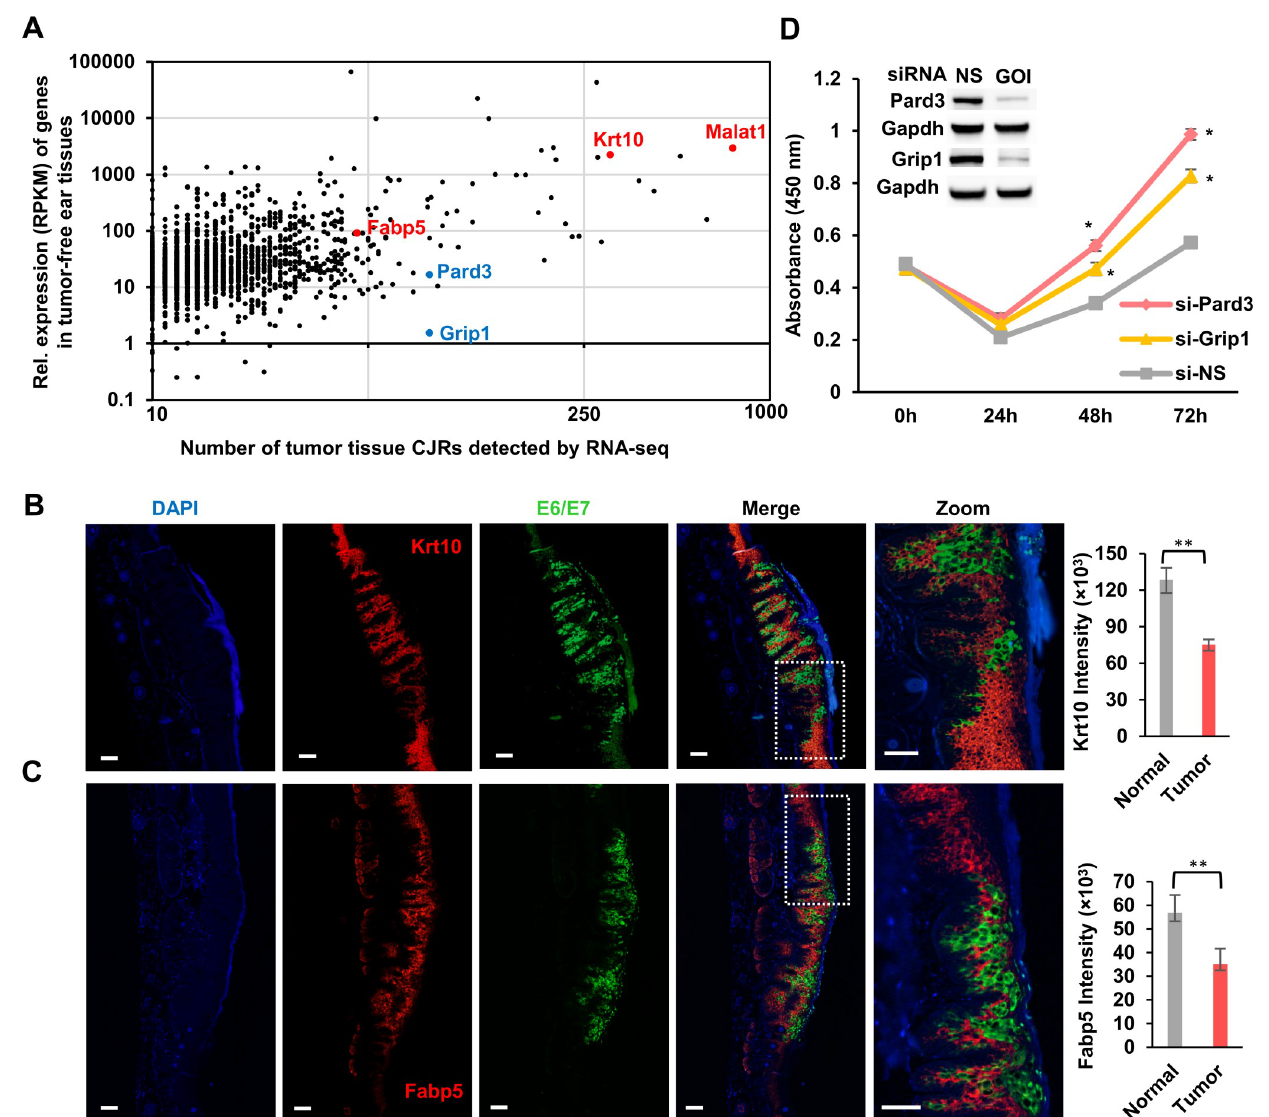
Fig 6. MmuPV1 integration, host gene expression, and cell growth. A, MmuPV1 integration sites were found in genes that are expressed at both high and low levels. Each dot indicates a gene with the indicated level of expression (RPKM) in tumor-free ear tissues and the number of virus-host CJRs obtained from all tumor tissues by RNA-seq. RPKM is the Reads Per Kilobase of transcript per Million mapped reads in RNA-seq. B and C, Expression of MmuPV1 E6E7 (green) correlates with a decrease in the expression of mouse Krt10 and Fabp5 (red) in the tail tumor tissues of FoxN1 nu/nu at day 21 as measured by RNA ISH using dual immunofluorescence RNAscope analysis. Nuclei were stained with DAPI (blue). Scale bar, 100 μ m. Krt10 and Fabp5 levels in four randomly selected tumor tissues (that express E6E7) and four tumor-surrounding normal tissues (that do not express E6E7) were quantified by Image J, averaged, and shown as a bar graph on the right. Statistical comparisons were computed by unpaired, two-tailed Student’s t test. �� p < 0.01. D, Knockdown of Pard3 or Grip1 expression by gene-specific siRNA promotes cell proliferation. The siRNA knockdown of Pard3 and Grip1 expression in mouse primary keratinocytes was confirmed by Western blot, with Gapdh serving as a sample loading control. Primary mouse keratinocytes were transfected with 40 nM of siRNA twice at a 24 hr-interval and analyzed by a WST-8 cell proliferation assay. NS, non-specific siRNA; GOI, gene of interest. Data are the mean ± SE of three repeats. Statistical comparisons were computed by unpaired, two-tailed Student’s t test. � p < 0.05.